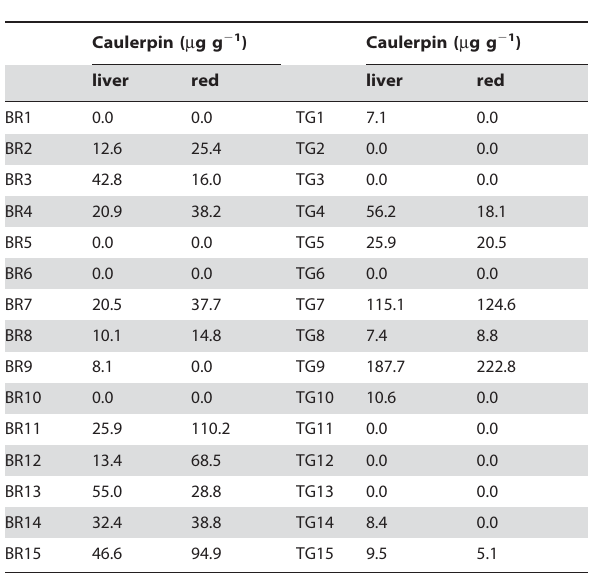
Table 1. Diet composition of D. sargus.